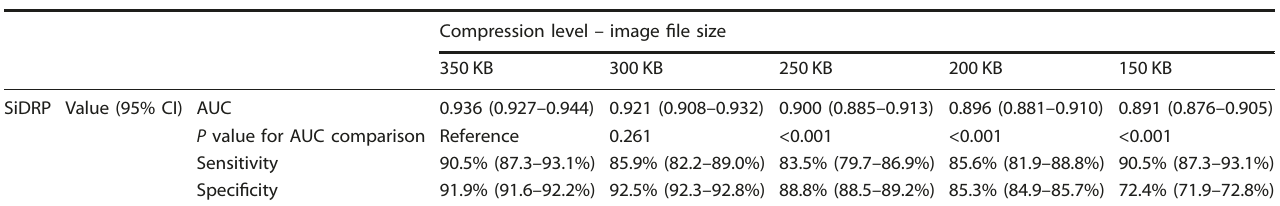
Table 4. Effect of image-related factors speci fi cally compression levels.